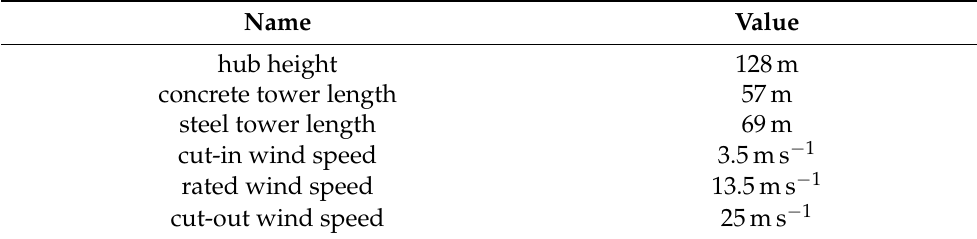
Table 1. Wind turbine REpower 3.4M